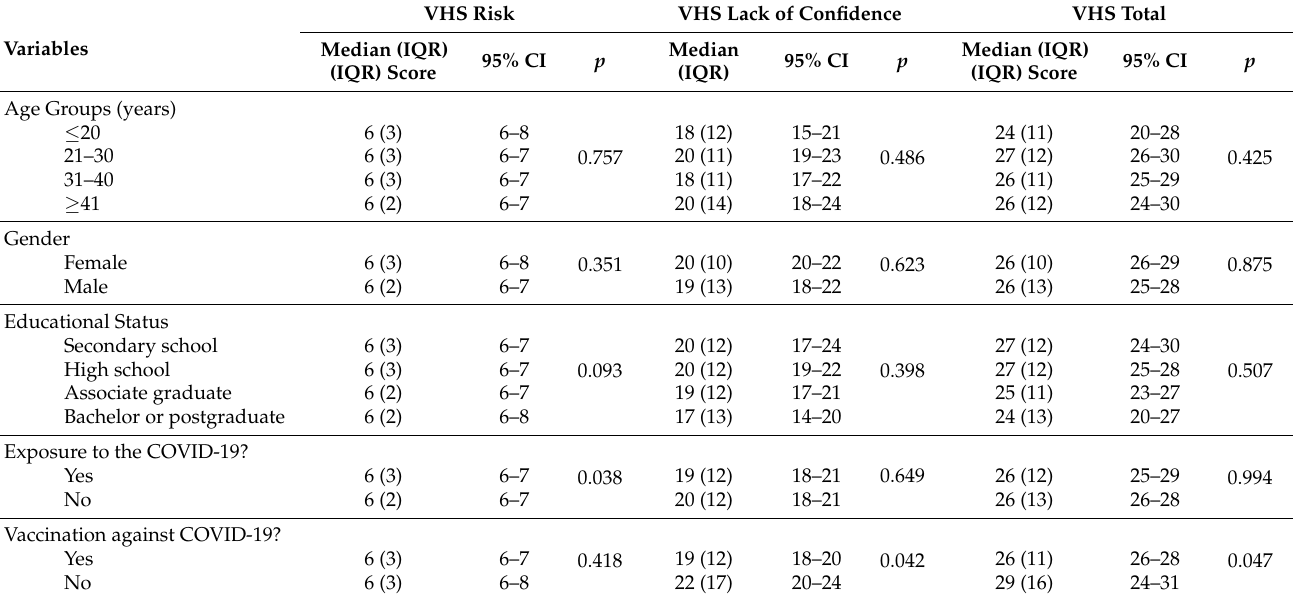
Table 4. Comparison of Vaccine Hesitation Scale Scores and Sub-Dimensions in Pandemics According to Various Variables of Personnel in the